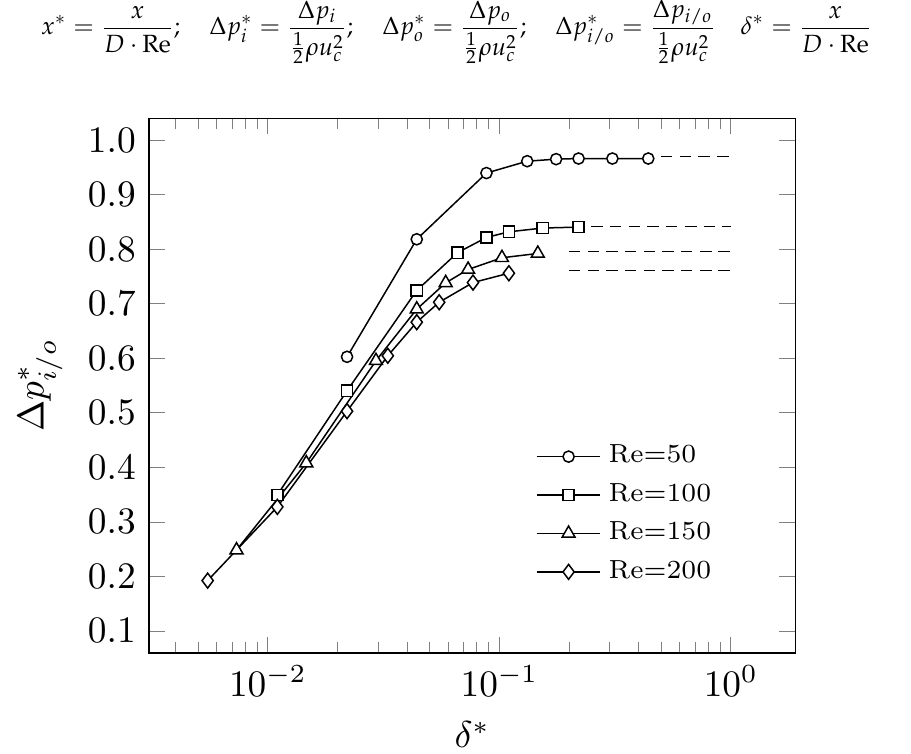
Figure 6. Dimensionless pressure drop between substrates. The dashed lines are the respective ( ∆ p ∗ + ∆ p ∗ o ) values for each i